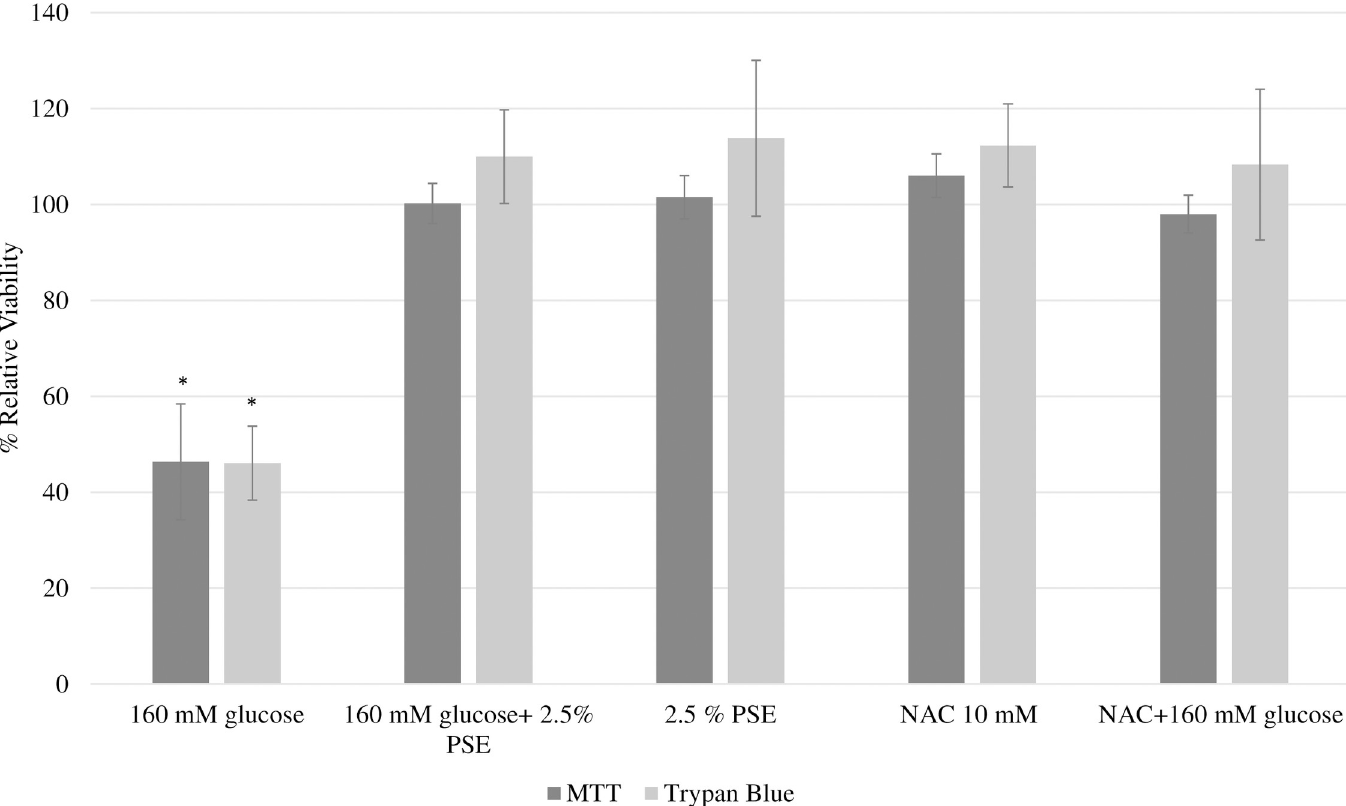
Fig 5. Effect of PSE on high glucose induced cytotoxicity in HepG2 cells viability measured by (A) MTT cell growth assay and (B) trypan blue exclusion method. HepG2 cells were exposed to either glucose, peanut skin extract (PSE), glucose and peanut skin extract (PSE), n-acteyl cysteine, or n-acetyl cysteine and glucose for 24 hours. N-aceytl cysteine is an antioxidant and used as a positive control. The viability of the control was assumed to be 100% and the data are expressed as viability relative to the control. Each treatment was done in triplicate and data are expressed as viability relative to the control and as mean ± SEM. � Indicates statistically significant difference at P <